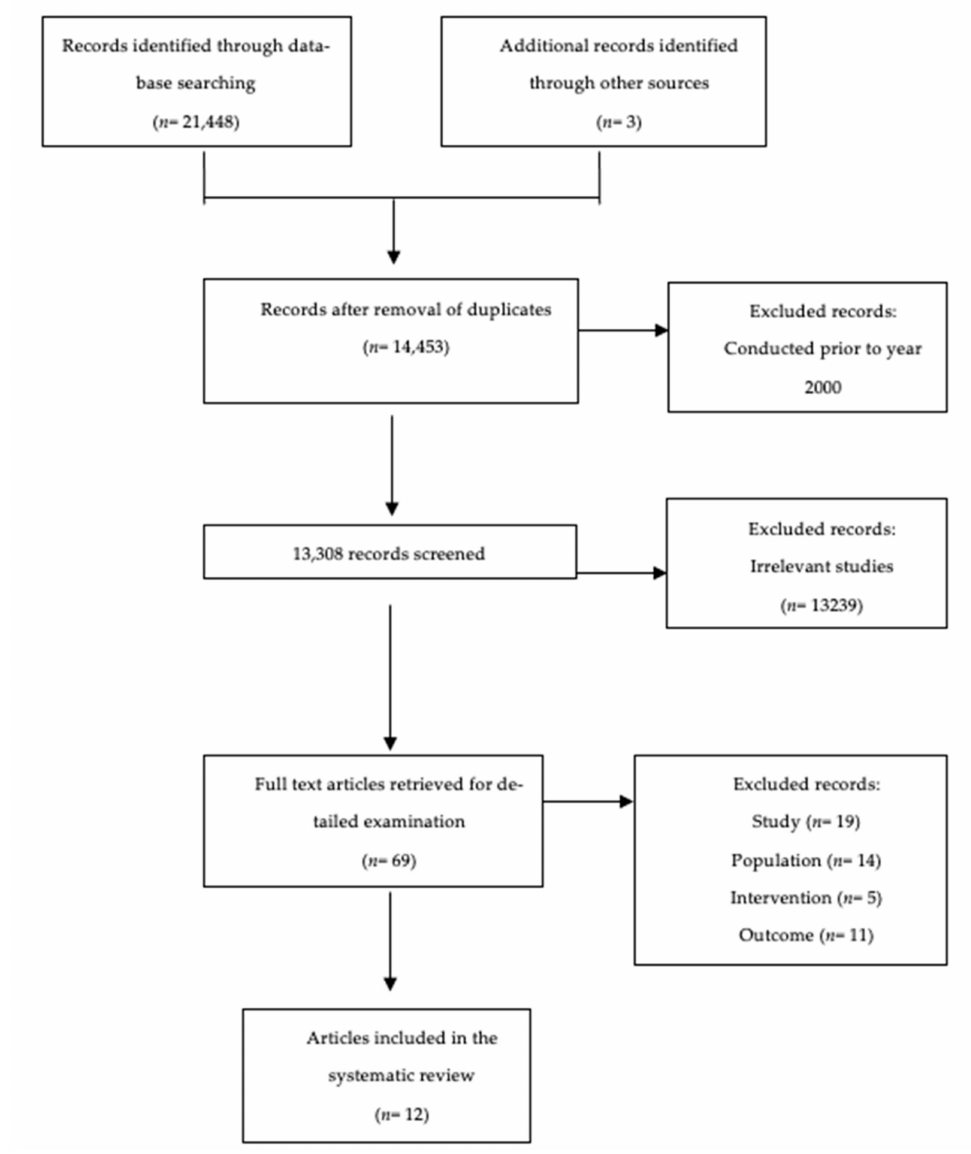
Figure 1. Study Selection Flow